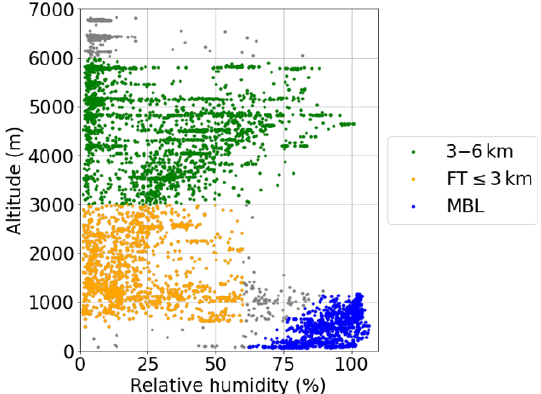
Figure 2. Observed vertical profiles of relative humidity, derived from the dew point measurements. The blue, orange, and green markers indicate the marine boundary layer (MBL), the lower FT, and mid-FT, respectively, as defined in the text. The gray markers indicate the data that do not belong to either group, with most of them in the